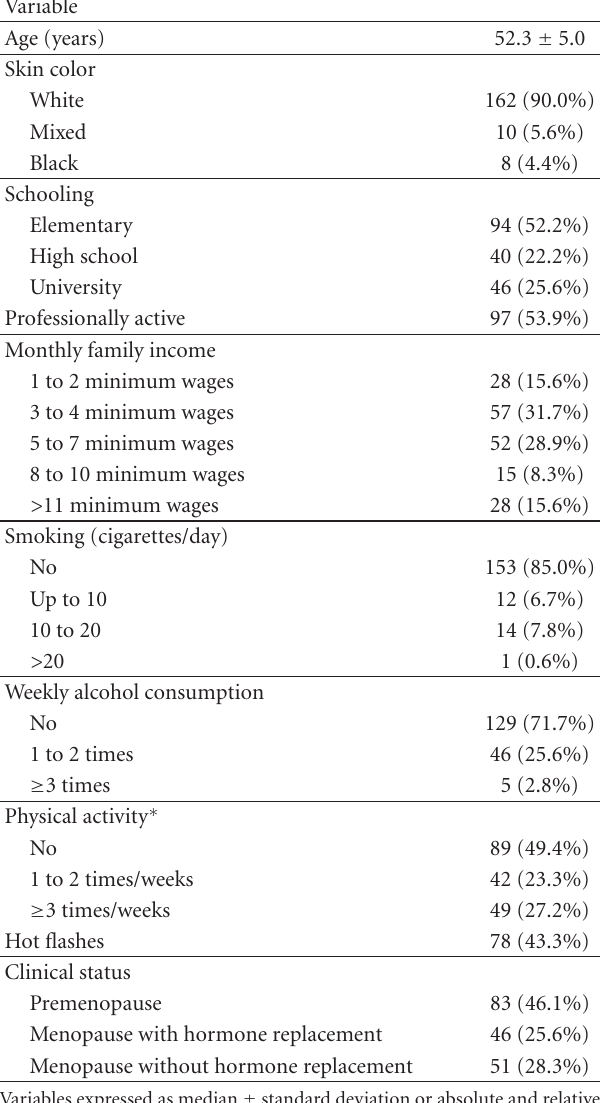
Table 1: Demographic characteristics of brazilian women partici- pating in the validation of the brazilian portuguese version of the cervantes scale ( n =